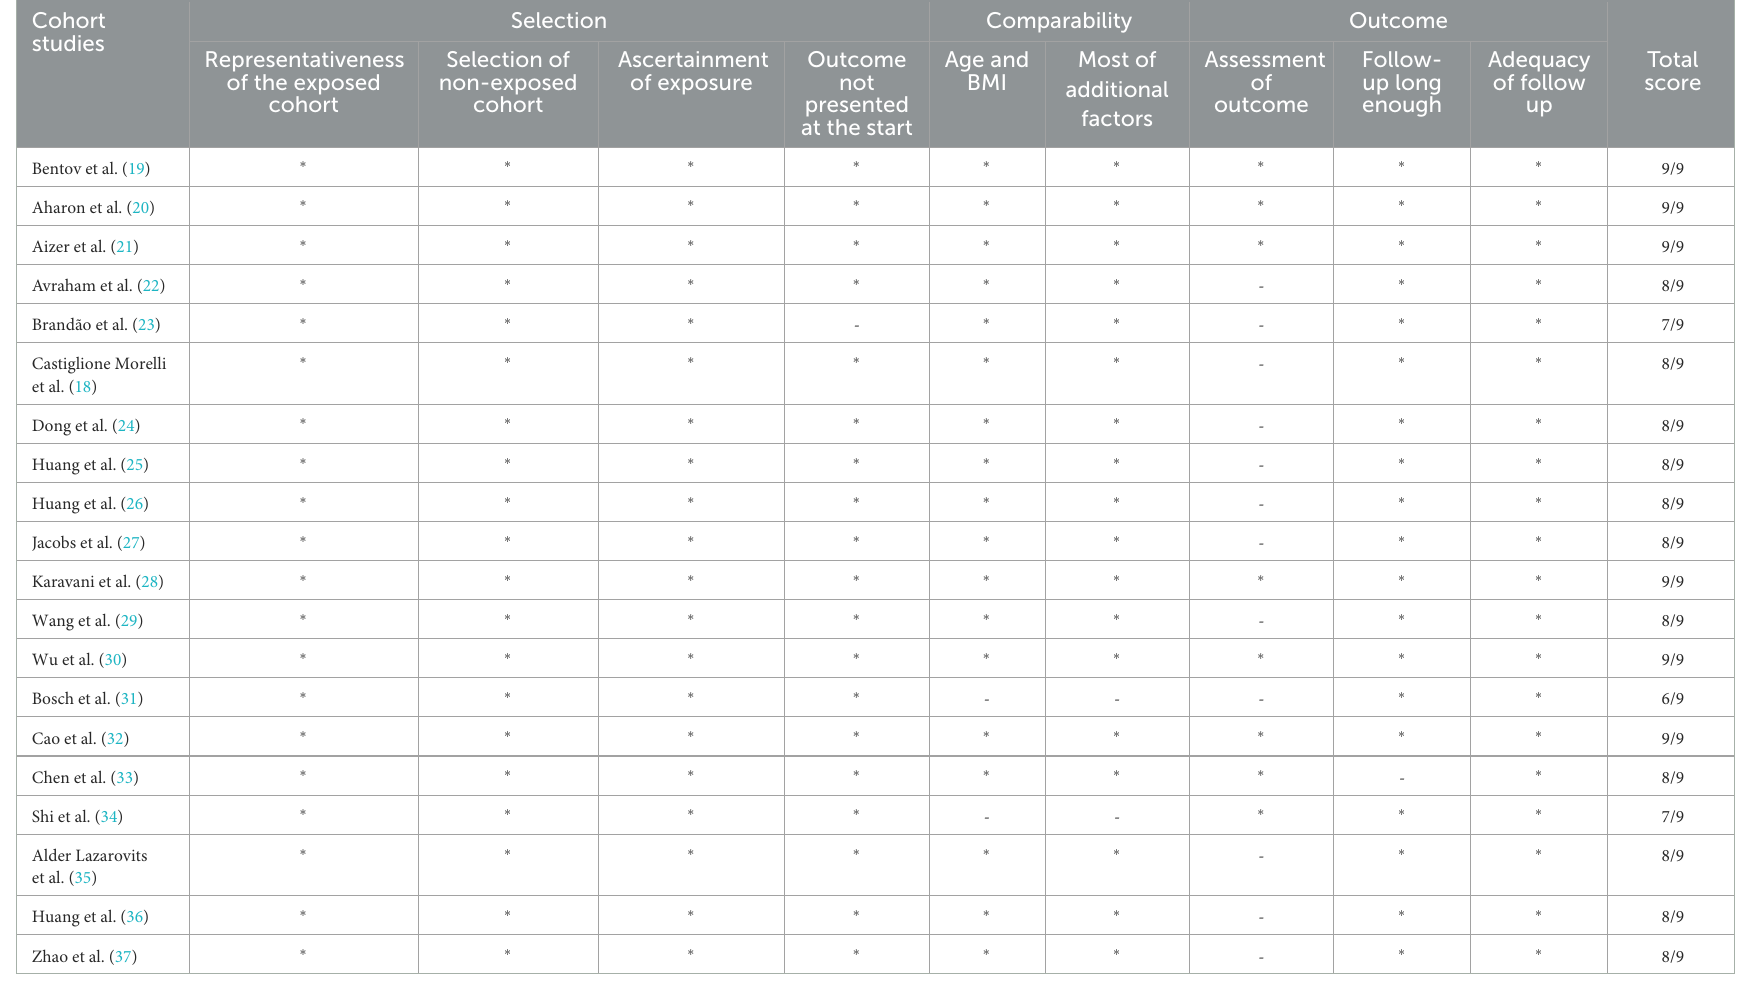
TABLE 2 Outcome of assessment of the quality of non-randomized studies using the Newcastle-Ottawa